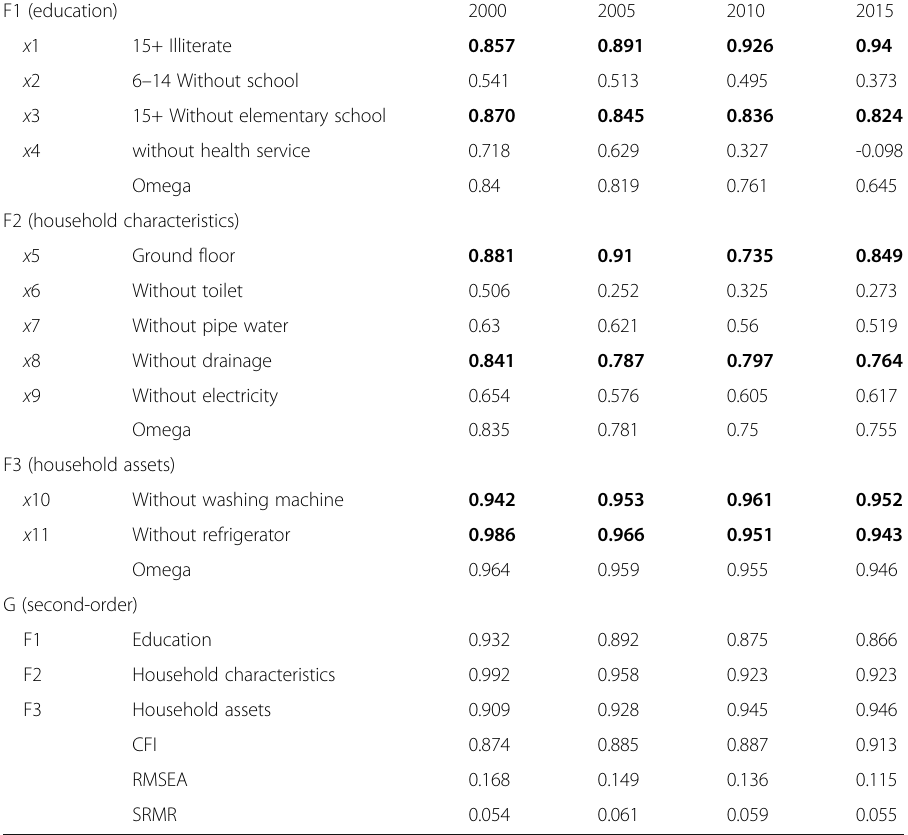
Table 3 Factor loadings corresponding to the second-order CFA F1